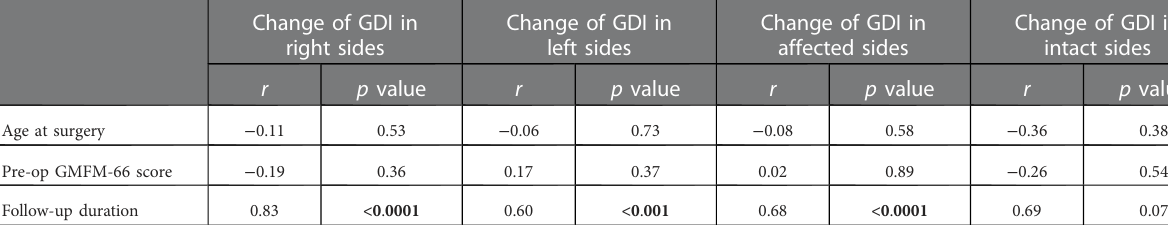
TABLE 2 Correlation between gait deviation index (GDI) change and different variables. Change of GDI in Change of GDI in Change of GDI in Change of GDI in right sides left sides affected sides intact sides r p value r p value r p value r p value